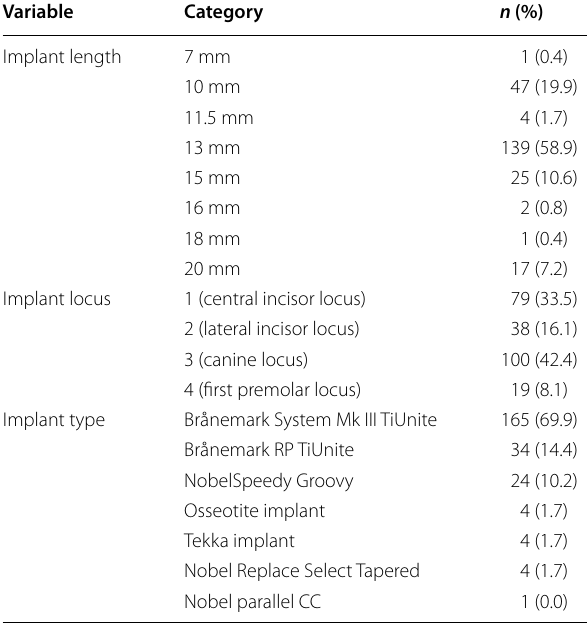
Table 3 Anterior implant variables